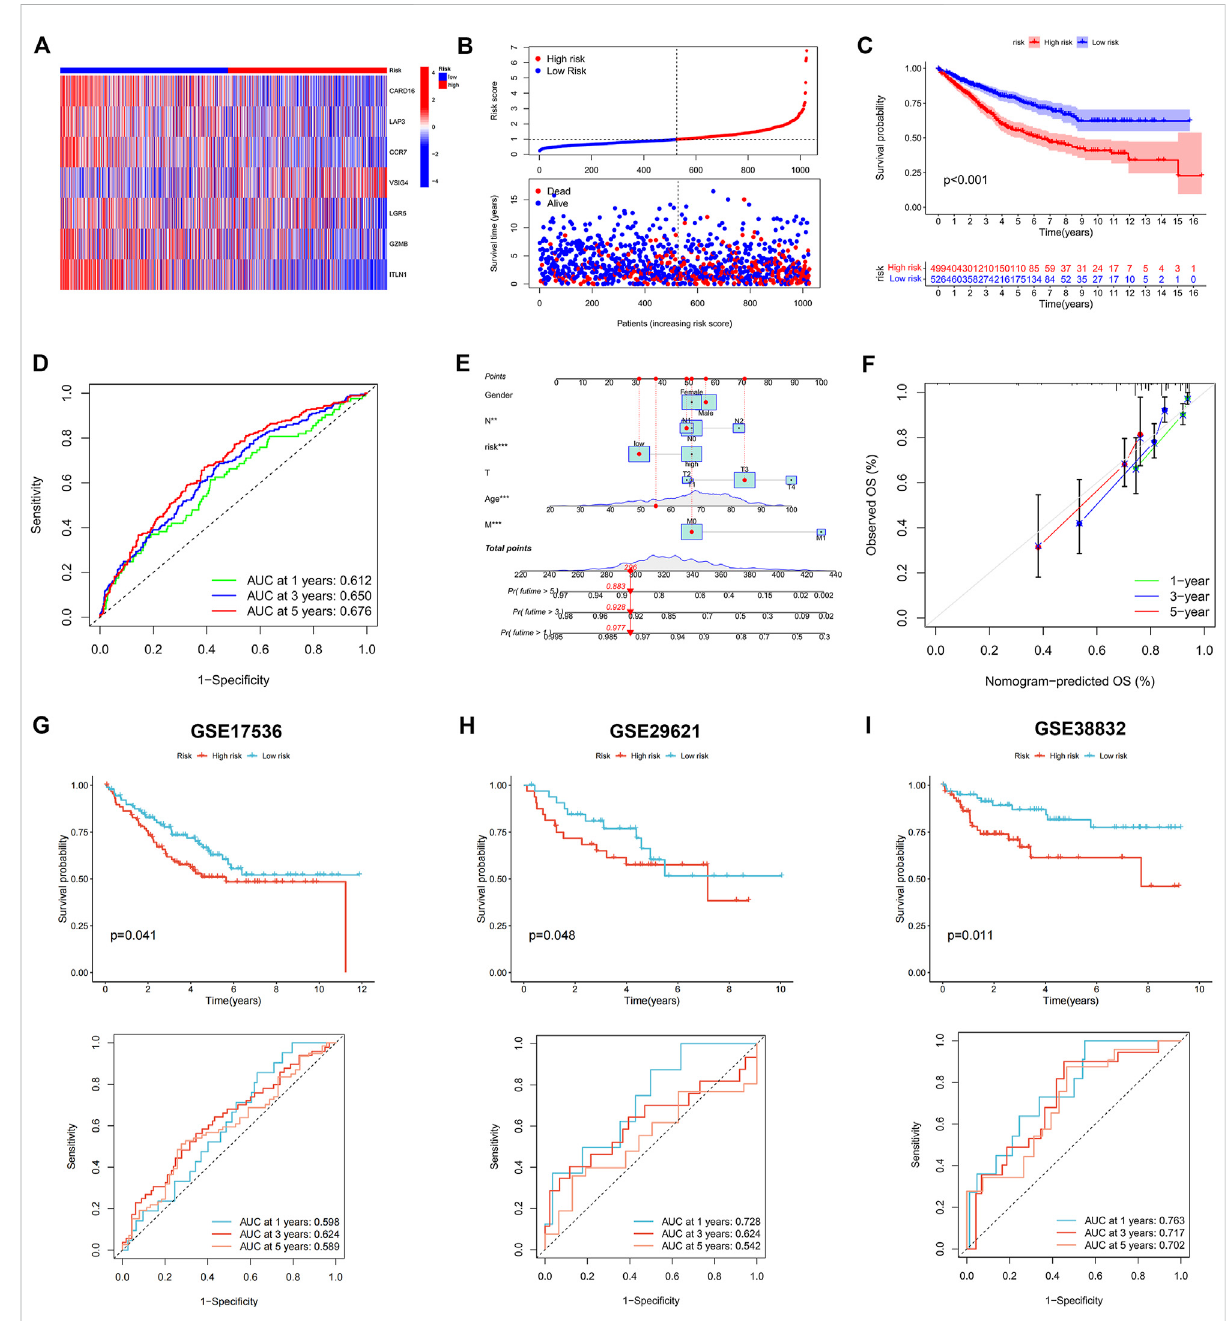
FIGURE 5 Construction and validation of the prognostic signature. (A) Heatmap showed the expression of 7 genes in two risk groups. (B) Risk score and survival outcome of each case. (C) KM curve showed that patients in high-risk group had a worse prognosis. (D) The AUC for 1-, 3- and 5-years survivalwere0.612,0.650,and0.676,respectively. (E) Nomogramusingriskscoreandotherclinicalfeatureswereconstructedforpredictingsurvival ofcoloncancerpatients. (F) Calibrationgraphsinvestigatedthattheactualsurvivalratesofcoloncancerpatientswereclosetothenomogram- predictedsurvivalrates.TheKMandROCmethodswereusedtoevaluatetheef fi ciencyoftheriskscoreatpredictingpatientsurvivalinGSE17536 (G) , GSE29621 (H) , and GSE38832 (I) CRC